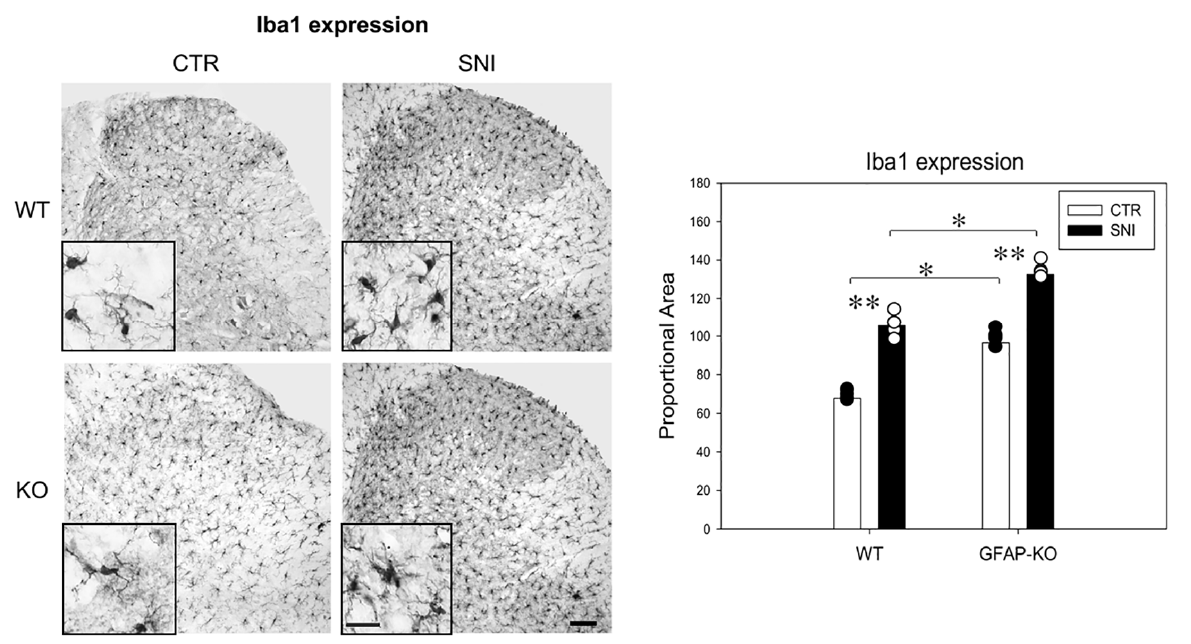
Figure 2. Microglial Iba1 expression in the dorsal horn of the spinal cord. Iba1 expression increased after SNI in both WT and KO animals. Iba1 level detected in CTR ‐ KO animals was higher than that in CTR ‐ WT mice (magnification 10×; scale bar, 50  m). Inset : higher magnification (40×) view of microglial cells, showing morphological features in CTR and nerve ‐ injured mice (scale bar, 50  m). (Data are expressed as the mean ± SEM with individual data points; ** p ≤ 0.001; * p ≤